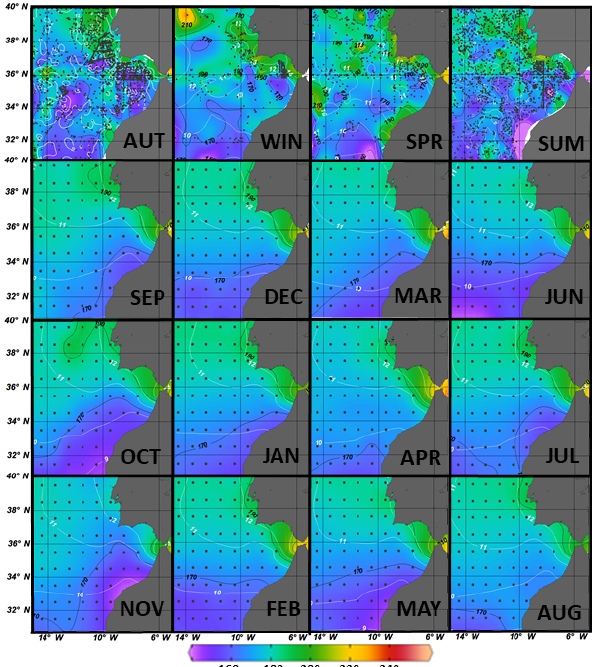
Figure 4. Observed oxygen concentration on the isopycnic surface σ = 27 . 5 for the different seasons (top row). The rows below show the same distributions for each climatological month as shown by WOA data. The white lines represent the temperature values at den- sity σ = 27 .